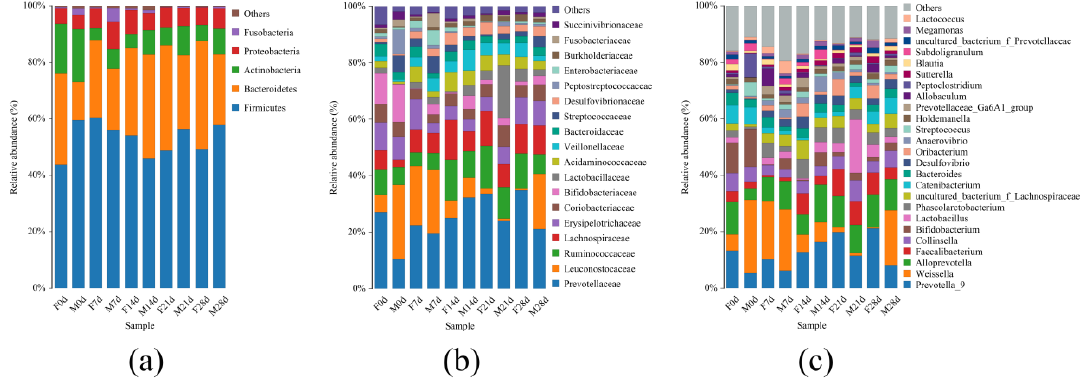
Figure 4. Relative abundance of microorganisms in fecal samples from blue foxes reared on different protein sources at the phylum ( a ), family ( b ), and genus ( c ) levels.